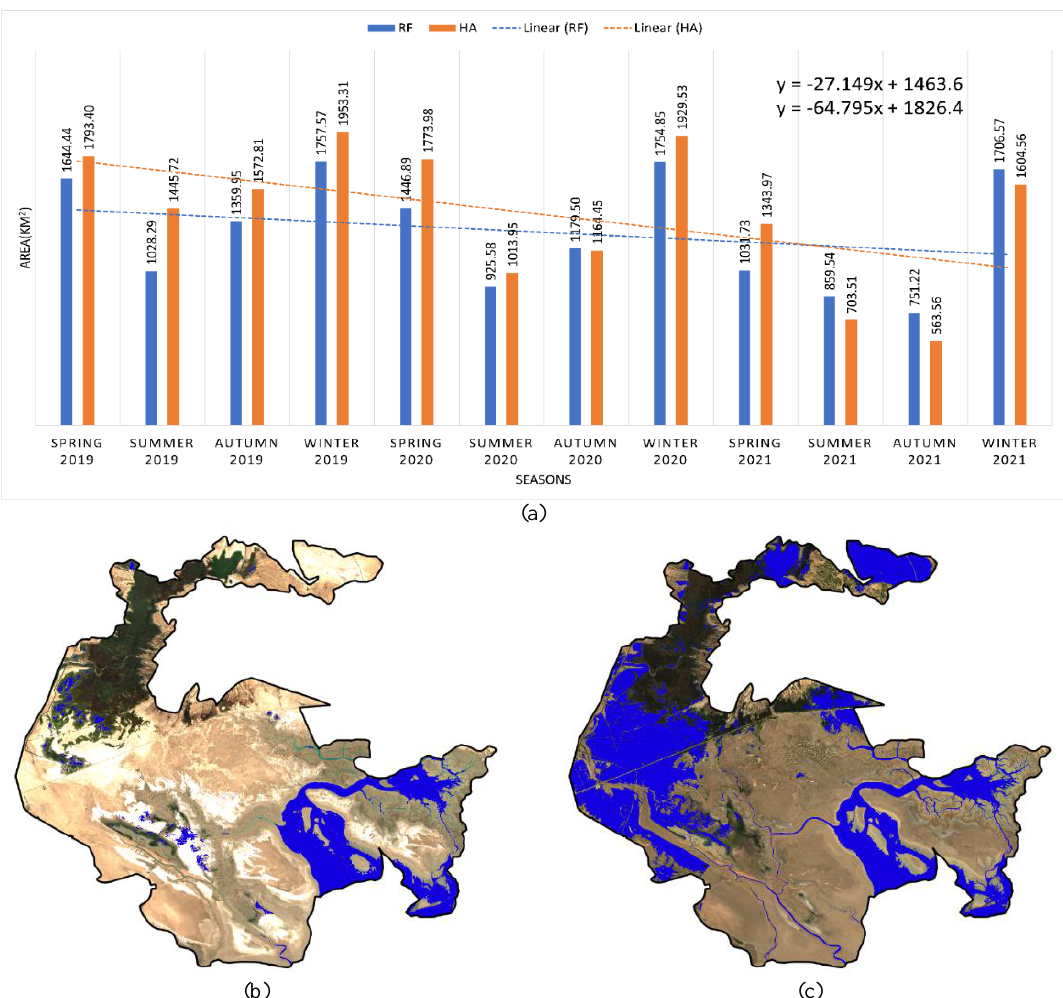
Figure 4. Variations in the water area of ISW during 2019-2021: (a) Mean water area changes in ISW for each season from 2019 to 2021. and (b) Minimum and (c) Maximum WE of ISW in this